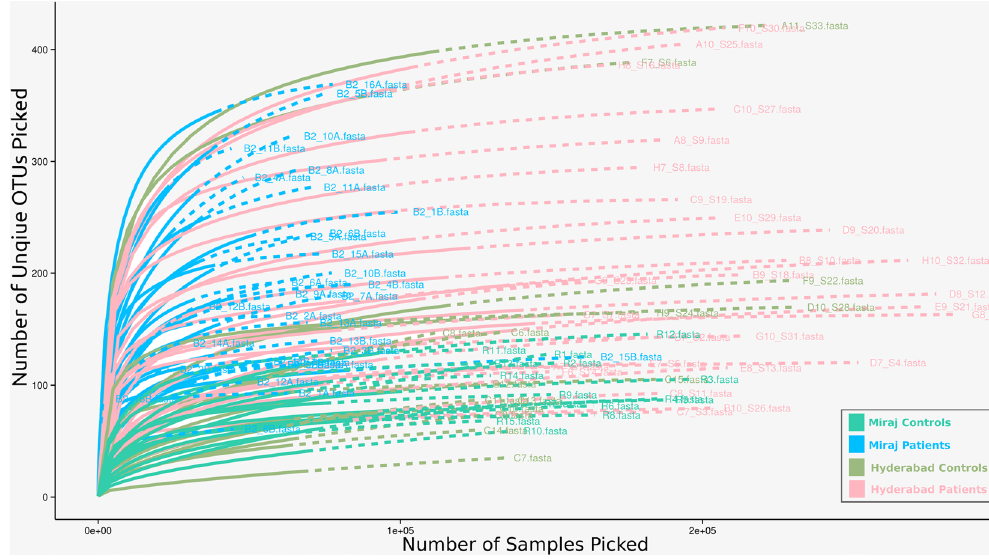
Figure 1. Rarefaction analysis of samples used in the present study. Rarefaction plot for all 88 samples analysed in the present study. Plot indicates reasonable sequencing coverage for most